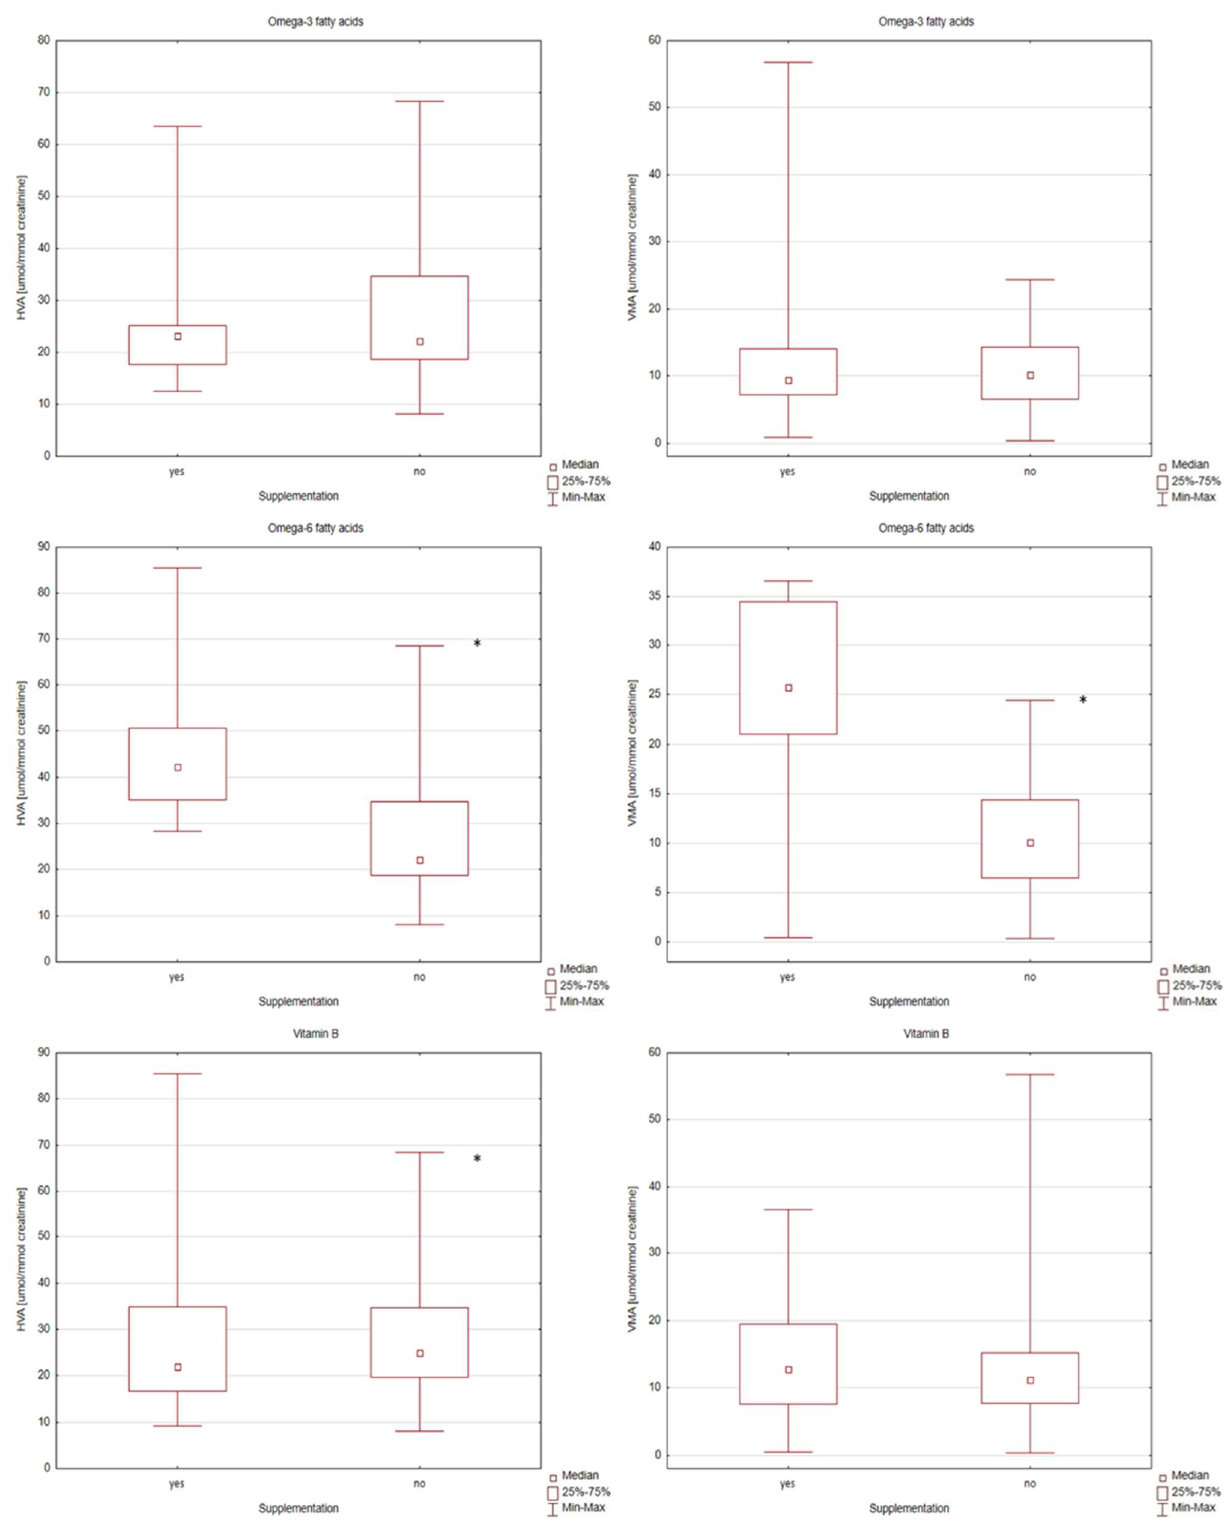
Figure 1. Box and Whisker plots for compounds determined in supplementation-categorized children with autism group (omega-3 and omega-6 fatty acids, vitamins B). In these box plots, medians inside the 25–75% interquartile range (IQR) are presented. *—statistically significant with p -value < 0.05.